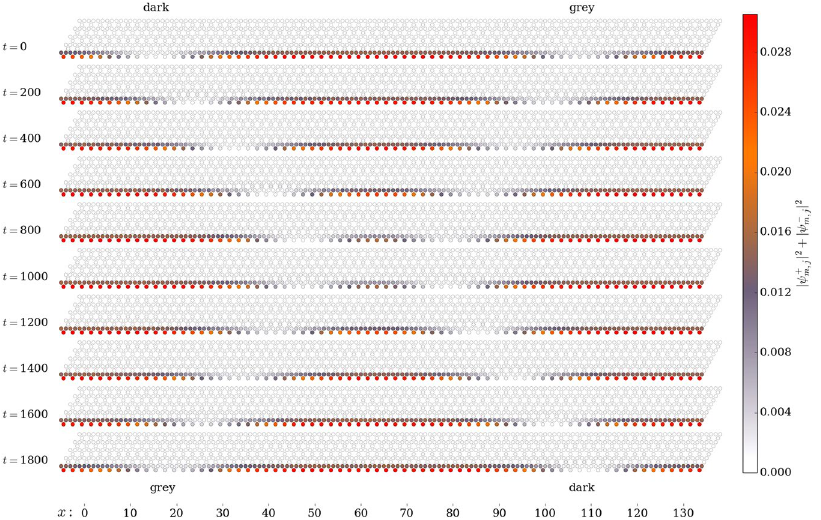
Figure 2. Simulation of collision of dark and grey solitons excited on the TEM propagating along the lower boundary of the kagome lattice strip in Fig. 1a. The TEM is excited at quasimomentum k e = 1.59, E ( k e ) = − 1.09 at δ J = 0.15, Ω = 0.3, in the vicinity of the blue spot on Fig. 1b. At t = 0 initial conditions in the form of dark (18) (on the left) and grey (19) soliton (on the right) with η = 0.25 have been taken upon applying the transformation (15) with v = 0.042. The grey soliton parameter θ was taken to be 0.4 π . At t > 0 the dark and grey move with constant velocities until the scattering act occurs at t ≈ 900, following which the dark and grey solitons exchange